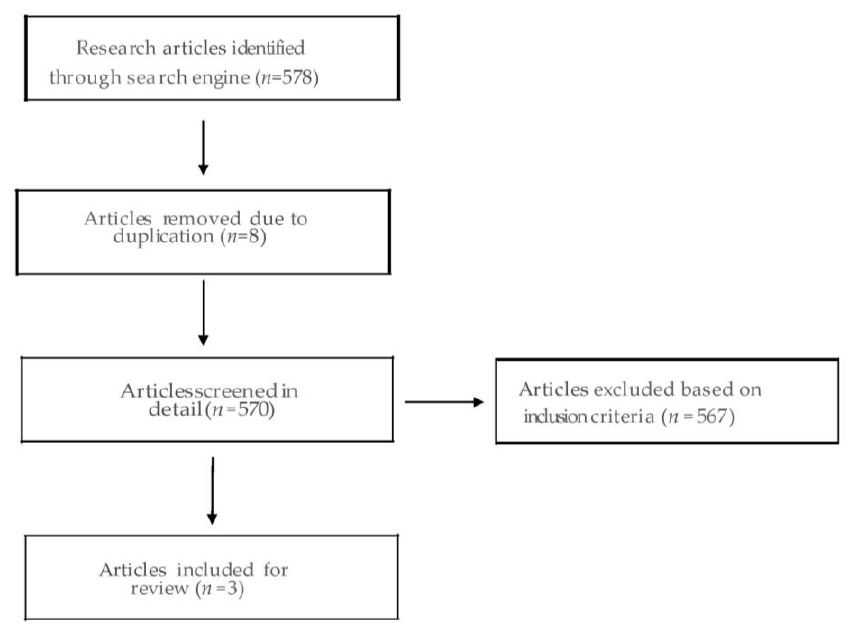
Figure 1. The flowchart showing database literature search and the method of shortlisting articles for review.